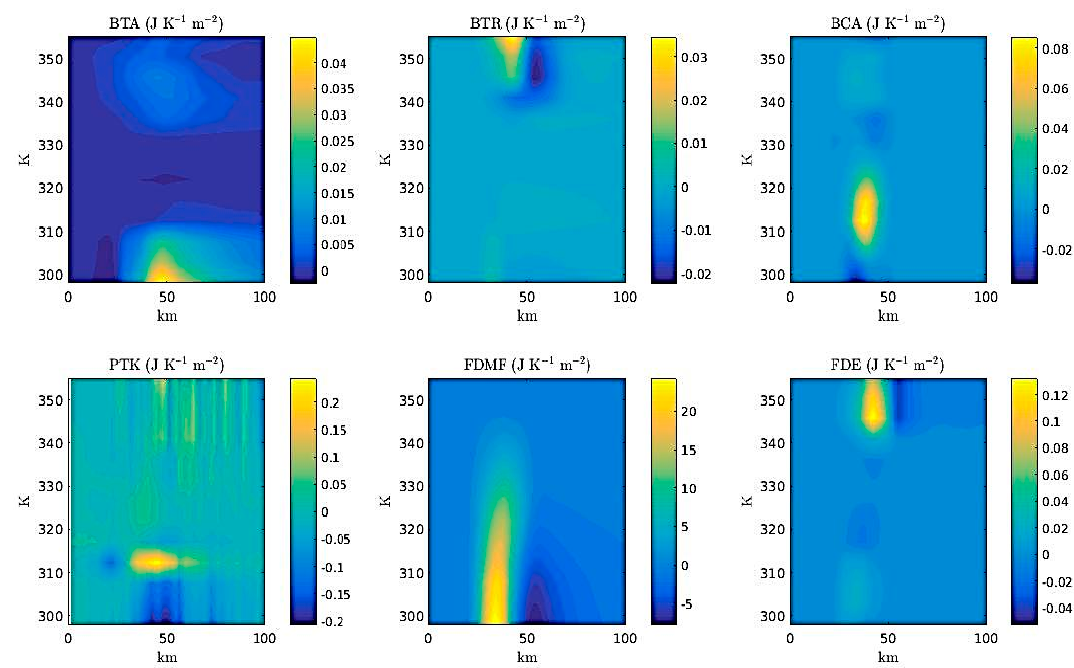
Figure 13. Azimuthal-mean eddy kinetic energy at (cid:1872) = 4 h. BTA corresponds to barotropic energy conversion associated with the azimuthal flow, BTR corresponds to barotropic energy conversion associated with the radial flow, BCA corresponds to baroclinic energy conversion associated with the azimuthal and radial flow, PTK corresponds to the transfer of eddy potential energy into eddy kinetic energy, FDMF corresponds to the flux divergence of (cid:1837) (cid:3017) by the mean flow, and FDE corresponds to the flux divergence of (cid:1837) (cid:3017) by the eddies.